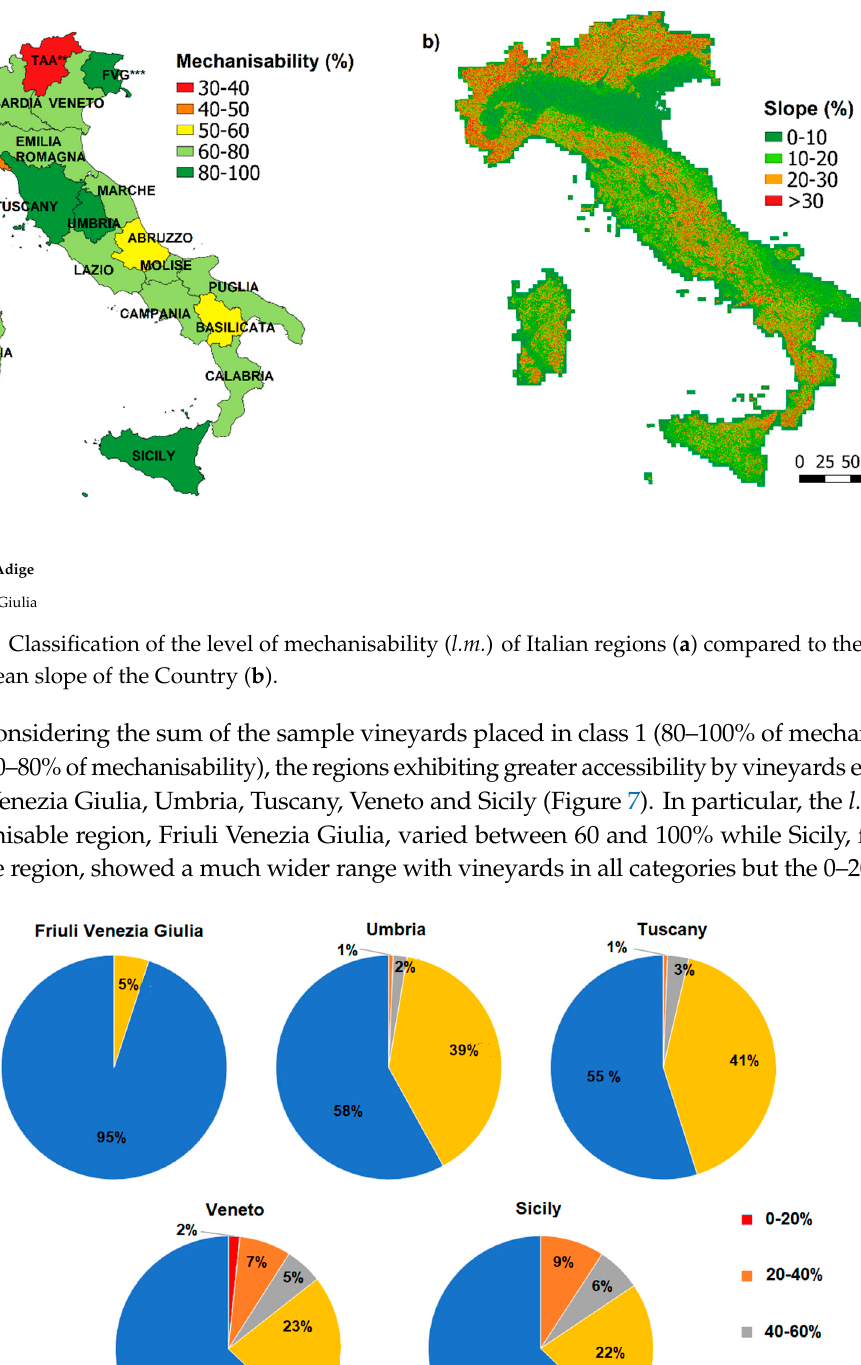
Figure 7. Classification by l.m. of the top five regions.